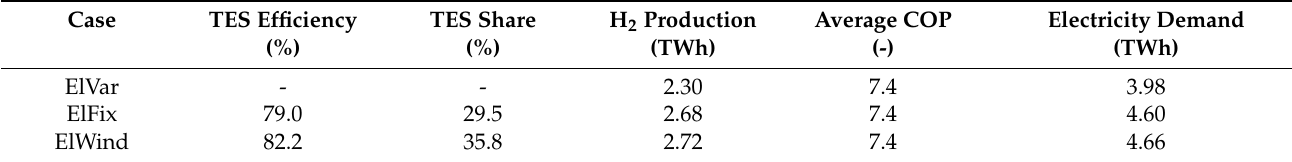
Table 4. Annual performance of the heating system.